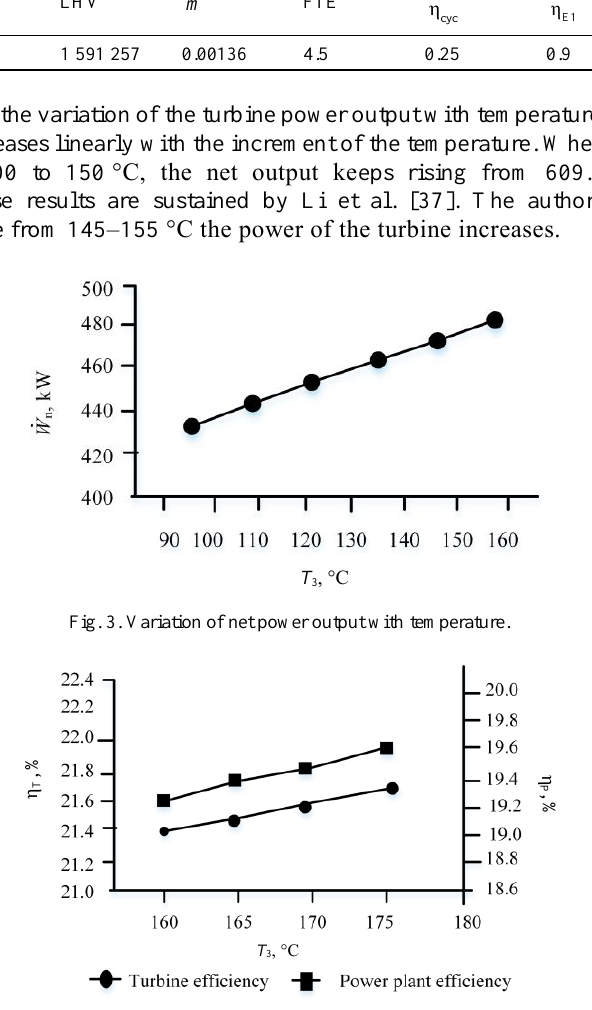
Fig. 4. Variation of turbines and power plant efficiency with